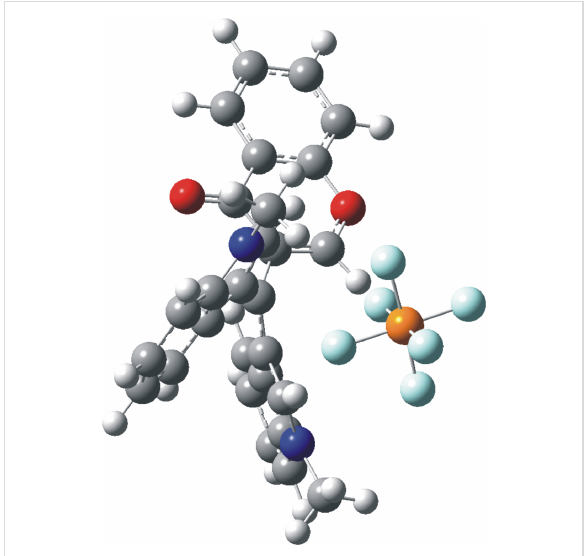
Figure 7: Optimized geometry of methylium-PF 6 salts 10 { 4,4,8 }.